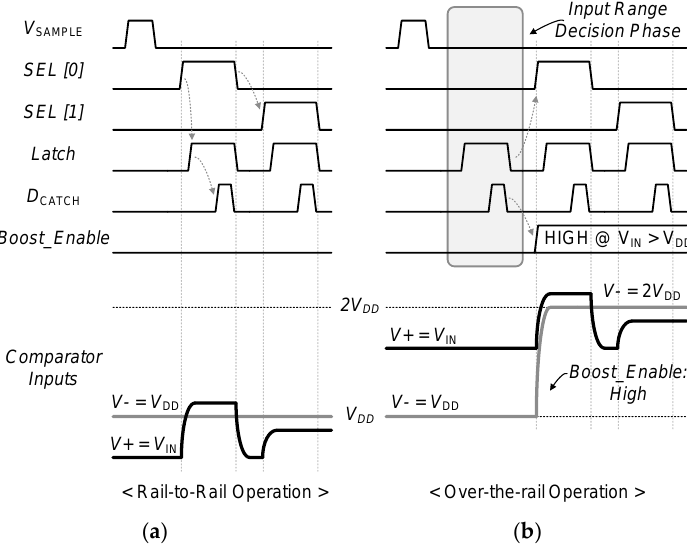
Figure 6. Operation of the input range boosting circuit for ( a ) rail-to-rail operation ( b ) over-the-rail operation.